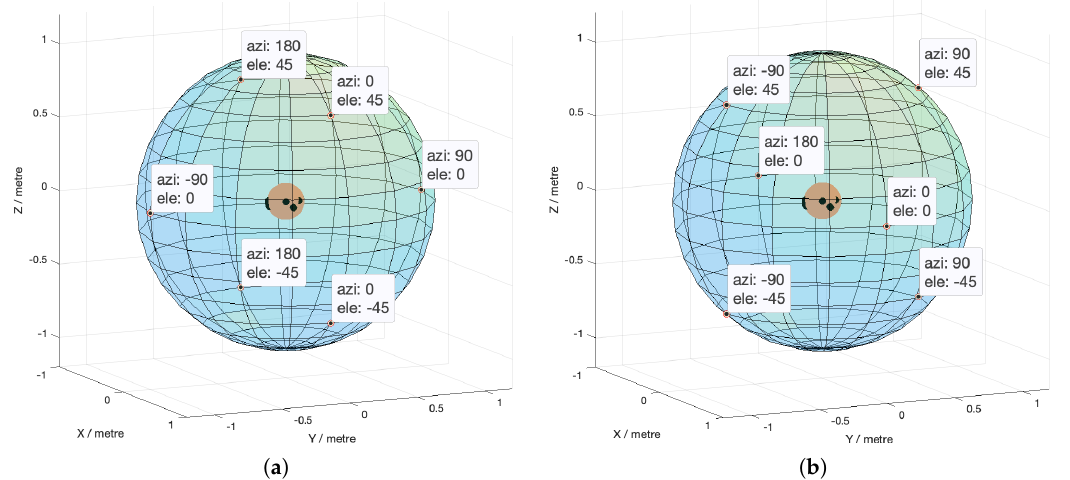
Figure 3. Selected HRTF data points ( a ) Angle selection for training, validation and testing. ( b ) Angle selection for training and validation only.